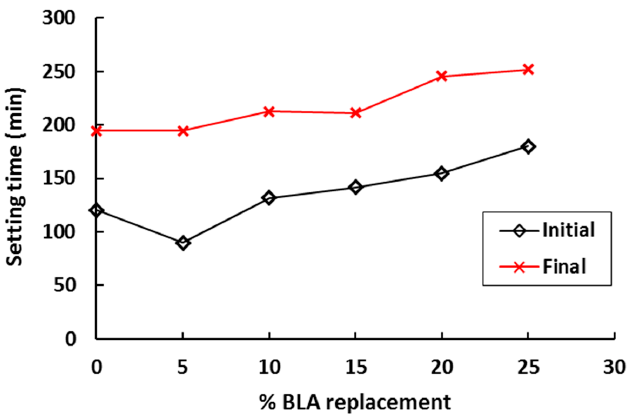
Figure 13. Influence of bamboo leaf ash on the setting time of concrete [115].